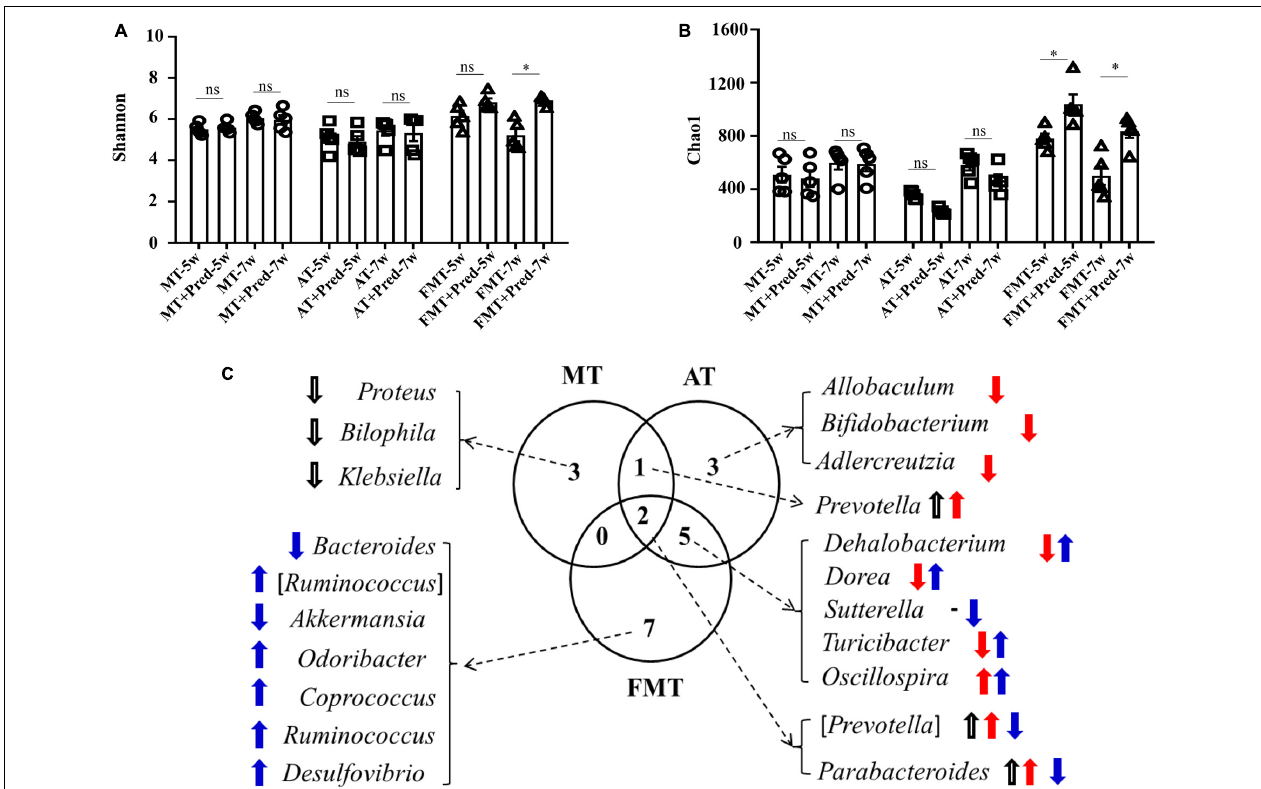
FIGURE 5 | Prednisone-induced alterations in alpha diversity [Shannon (A) and Chao1 (B) ] in the three types of MRL/lpr mice. Venn diagrams (C) show the distribution of shared and unique prednisone-induced microbial genera in the MT, AT, and FMT groups. NC, The C57/BL6 mice treated with PBS solution from 6 to 9 weeks old; MT, the MRL/lpr mice treated with PBS solution from 6 to 9 weeks old; AT: the MRL/lpr mice treated with antibiotics from 6 to 8 weeks old and PBS solution from 8 to 9 weeks old; FMT, the MRL/lpr mice treated with antibiotics from 6 to 8 weeks old and fecal microbiota transplantation from 8 to 9 weeks old. “ ∗ ” represents p < 0.05; “ns” represents no significant difference. Black, red, and blue arrows represent the alterations in control, antibiotic-treated and FMT treated mice, respectively. Up arrow represents an increase caused by prednisone; down arrow represents a decrease caused by prednisone. Pred, prednisone. N =